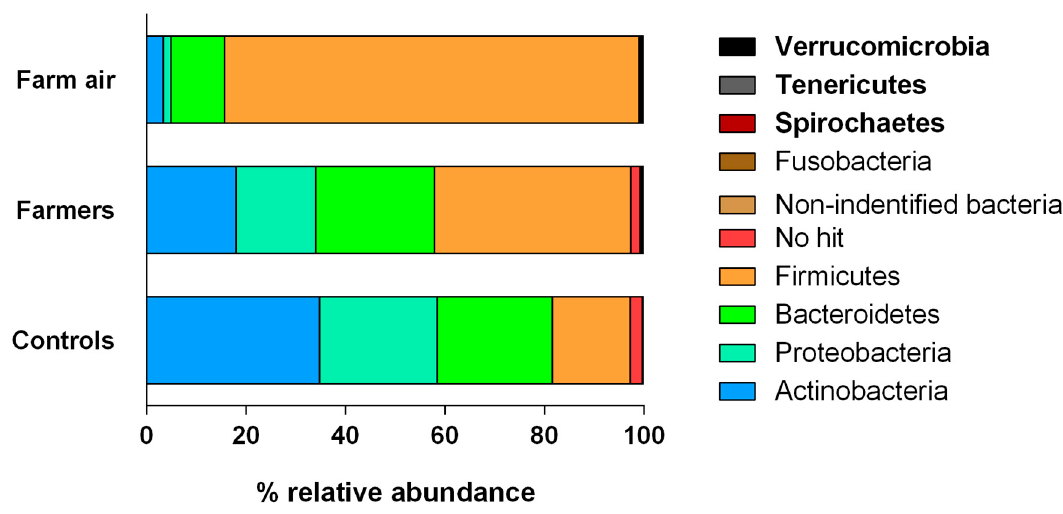
Figure 4. Taxonomic profiles showing the relative abundance of each bacterial phylum across nasopharyngeal flora samples from farmers, non-exposed controls and air samples from pig buildings. Phyla names written in bold type were specific to farmers and air from pig buildings.